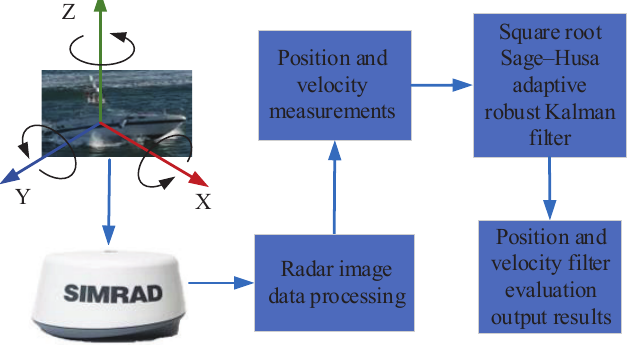
Figure 13. Lanxin USV experiment flow